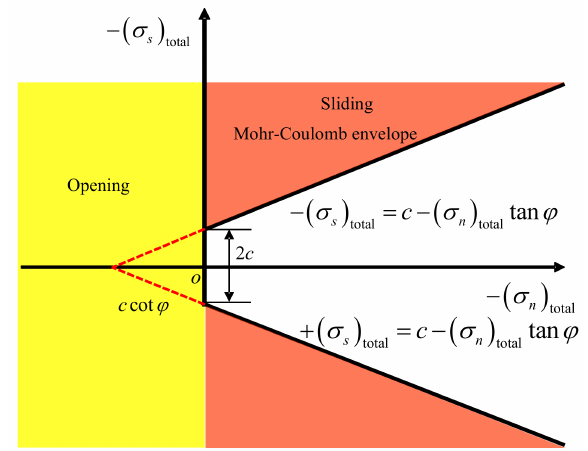
Figure 3. Mohr diagram of a joint element under different stress